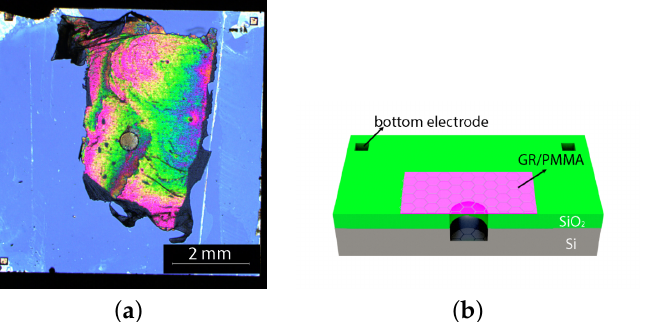
Figure 1. The optical image ( a ) and cross-section schematic ( b ) of the closed cavity resonator with 105 µm gap.